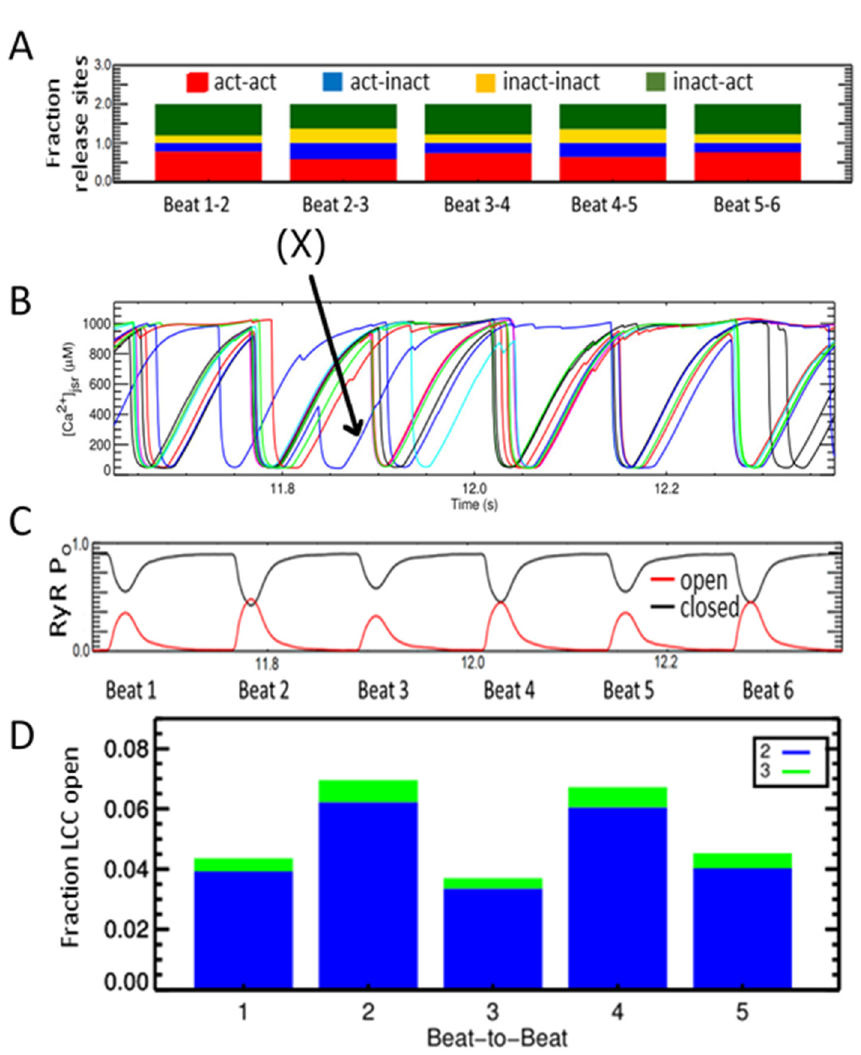
Figure 6. Alternans occurs at 8 Hz pacing rate. ( A ) An example that show a CRU that fires at two contiguous beats, e.g., (X) marks an individual release site that is Act-Act. ( B ) Alternans in the calcium release seen by the changing amplitude and duration of the [Ca 2+ ] myo . Beat-to-beat variation in CRU’s states where we examine act-act—the fraction of CRU that activate in beat ( i ) (red) and continue to activate in beat ( i + 1), similarly with act-inact (blue), inact-inact (yellow), and inact-act (dark green). ( C ) The probability of RyR opening at each beat (red = open, black = closed). ( D ) The fraction of LCC open (states O2-blue and O3-green) during each